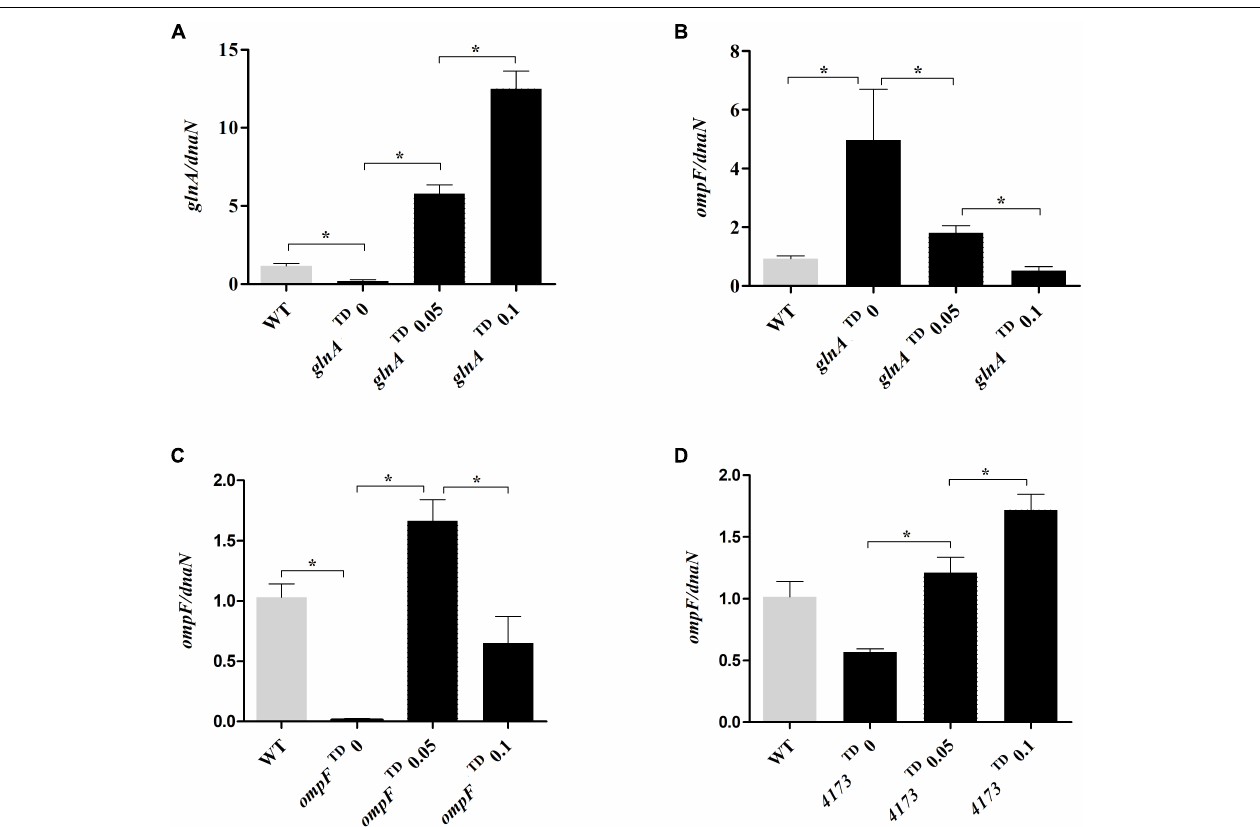
FIGURE 3 | Expression of ompF and its dependency in glnA expression. Expression level of glnA transcripts in the mutant glnA TD (A) and expression of ompF transcripts in the mutant glnA TD (B) , ompF TD (C) and 4173 TD (D) . The mRNA was extracted from tetracycline-dependent mutants under induced (0.05–0.1 µ g/mL CTET) and uninduced conditions. Expression of glnA or ompF was normalized to expression of dnaN and compared to expression of glnA or ompF in the WT strain without induction. Results are average of at least three biological replicates. Asterisks indicate significance, calculated by Student’s t -test, of results liked by brackets. * p ≤